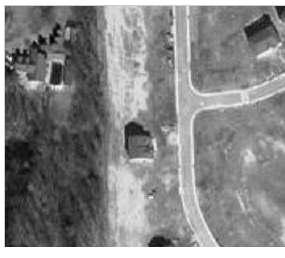
Figure 1: Salient road image